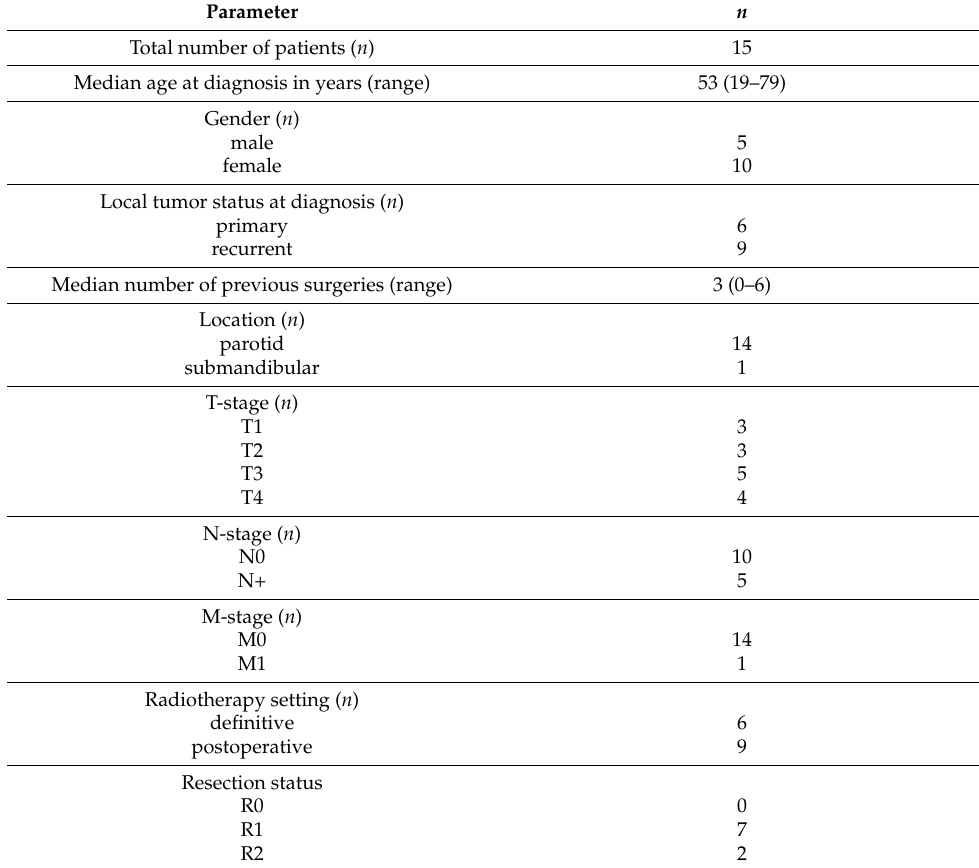
Table 1. General patient, tumor and treatment